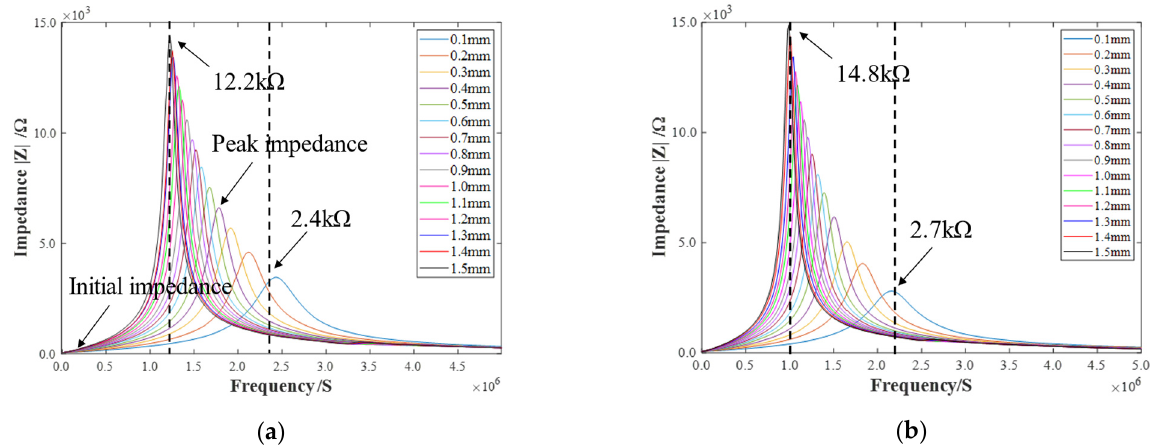
Figure 6. The impedance curves of ( a ) 153-turn receiving coil–backplate and ( b ) 173-turn receiving coil–backplate.